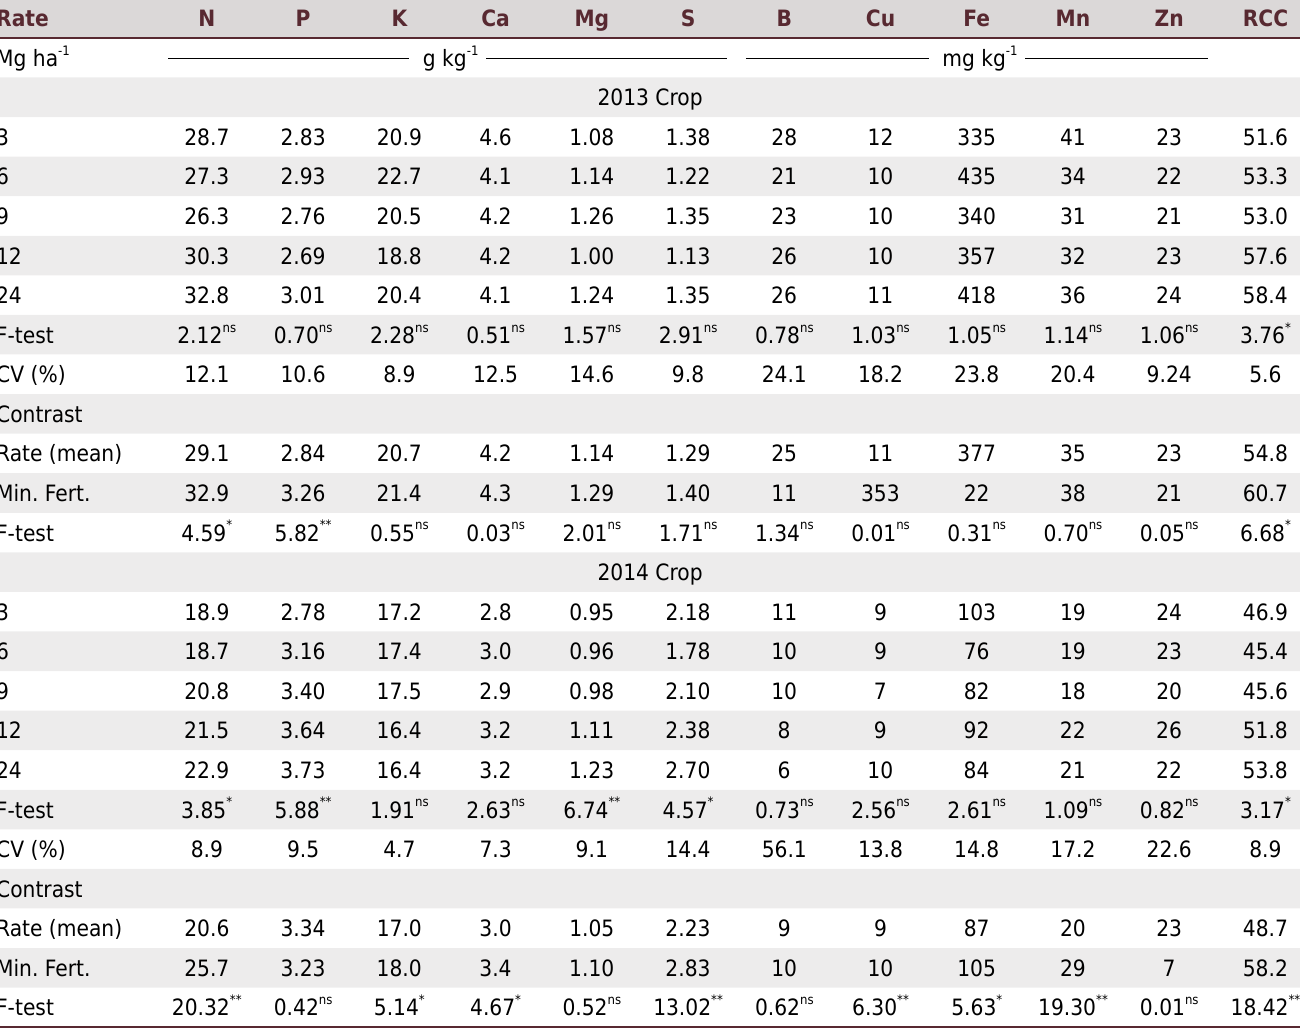
Table 5. Nutrients concetrations in corn leaves for the 2013 and 2014 crops, and summary of analysis of